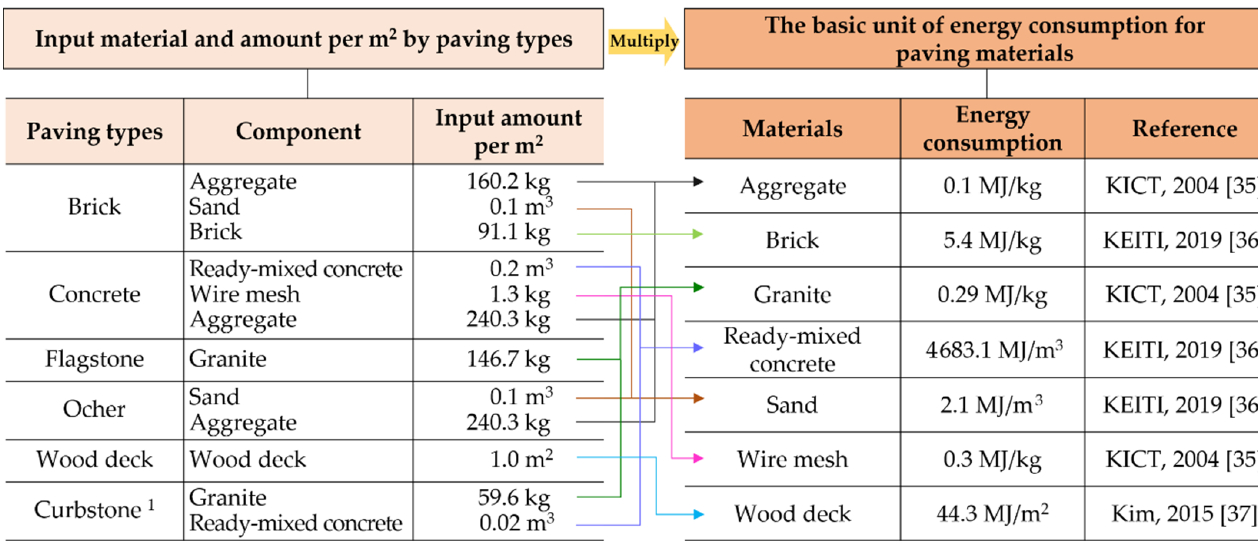
Figure 4. The calculation process of energy consumption per square meter by paving materials. 1 The unit of curbstone is piece instead of square meter [35–37].